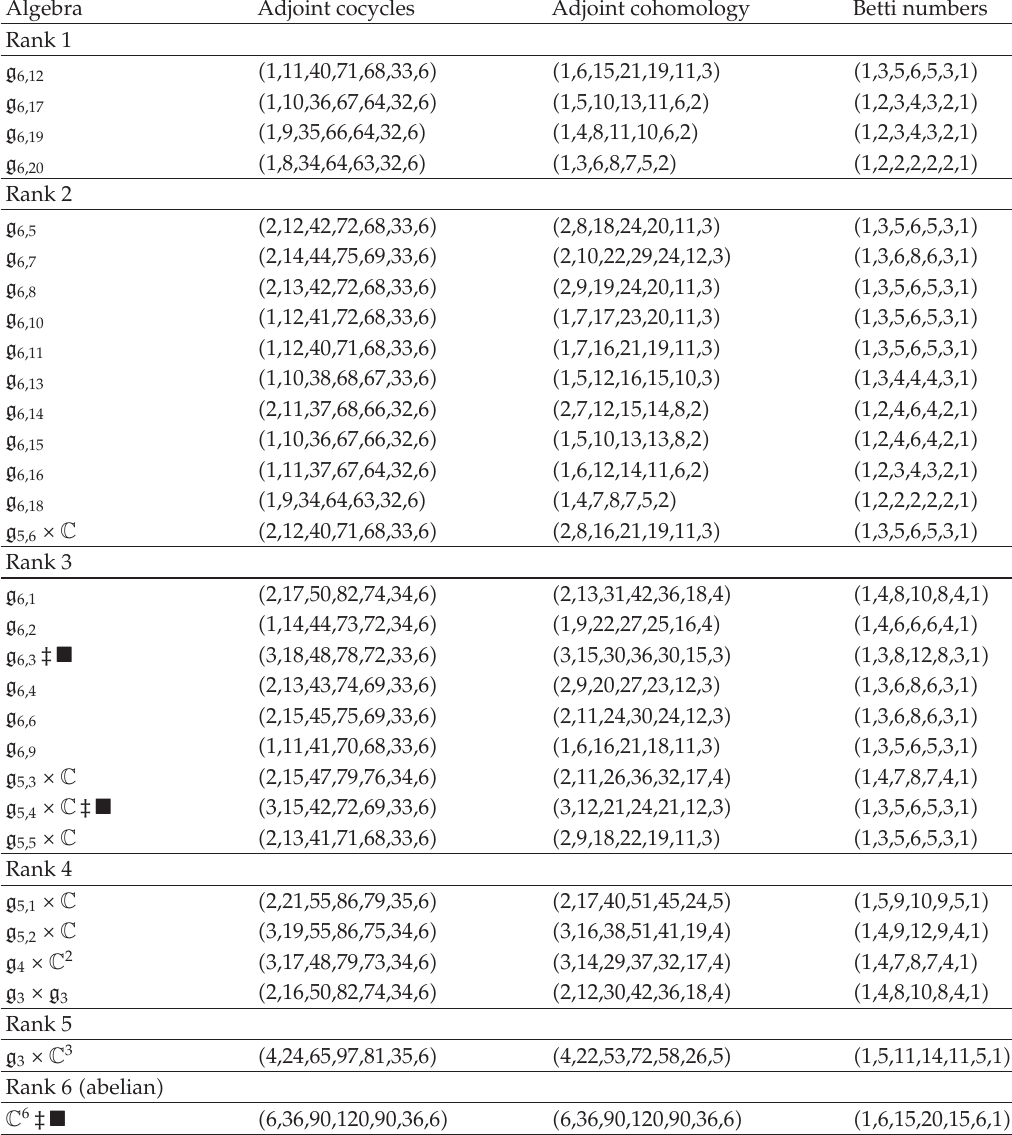
Table 11: Cohomology table for NLAs of dimension